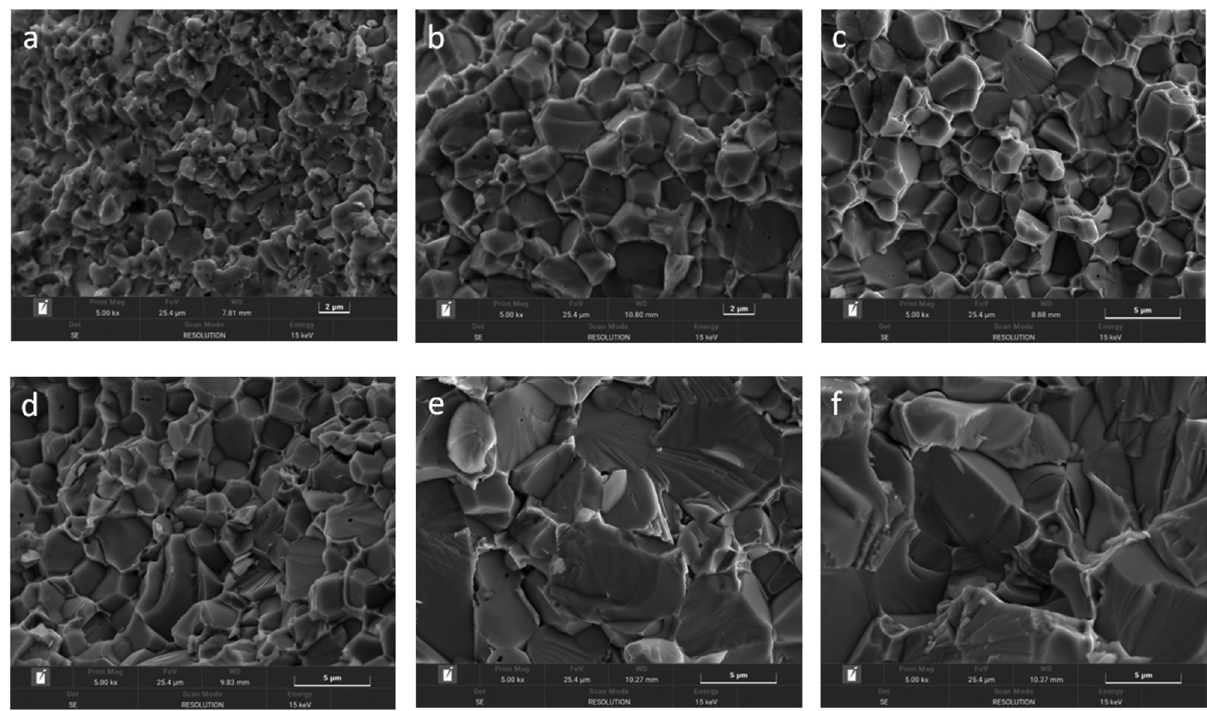
Figure 9: Fracture morphology of NbC – 12Ni cermets with di ff erent sintering temperatures: ( a ) 1,270°C, ( b ) 1,300°C, ( c ) 1,360°C, ( d ) 1,390°C, ( e ) 1,420°C, and ( f ) 1,450°C, and dwell time 15 min